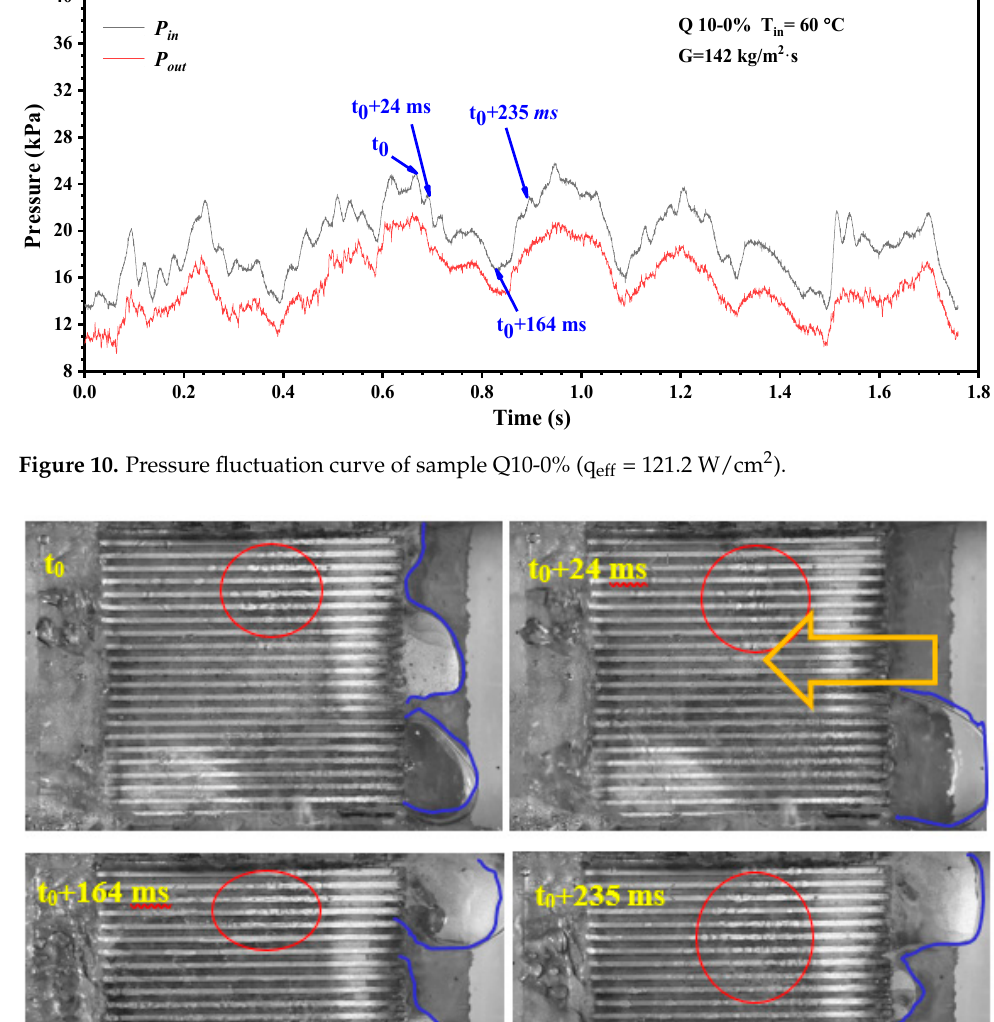
Figure 11. Visual picture of sample Q10-0% (q eff = 121.2 W/cm 2 ). Circle region: explosive boiling; Arrow: flow direction; blue line: vapor mass boundary.